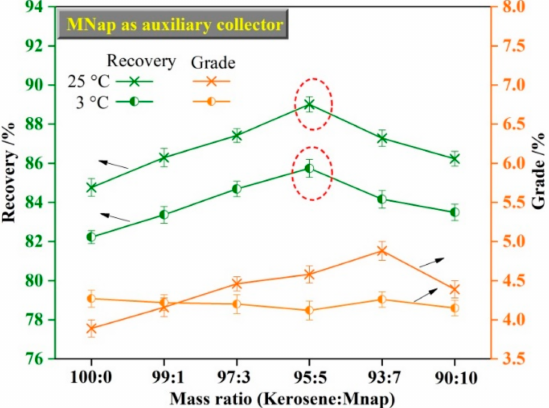
Figure 7. The effect of mass ratio of kerosene to MNap on molybdenite flotation (collector 170 g/t, frother 90